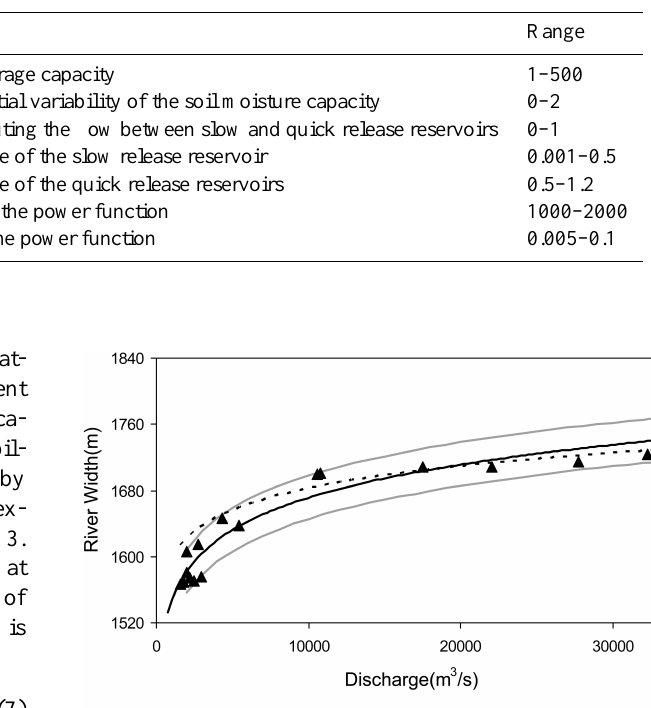
Table 1. Parameter descriptions and ranges of random sampling.